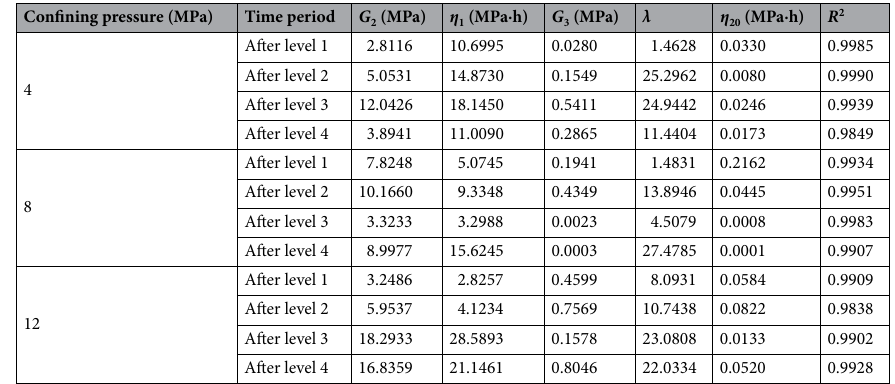
Table 3. Model parameter identification results in the unloading condition.